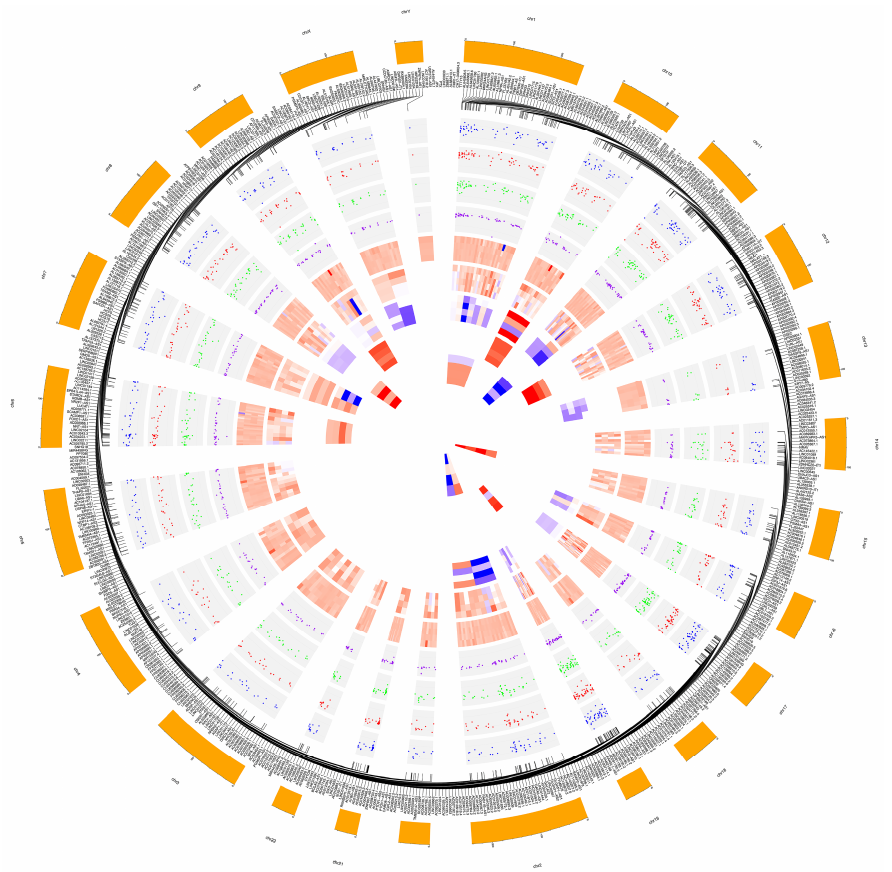
Figure 2. Circular plot made by CIRCOS [63] highlighting fold changes of significant dysregulated long non-coding RNAs (lncRNAs). Chromosome lncRNA host/target genes belong to and most dysregulated lncRNAs are labeled in the two outermost circles. Then, from outside to inside: dispersion plots of log 2 FC of all significant ( p < 0.05) different expressed lncRNAs in relationship to the whole treatment period (Due_to_Time), to the first considered time point vs basal time (3 h_vs_0 h), to the second time point vs basal time (6 h_vs_0 h) and to the second vs the first treatment time points (6 h_vs_3 h); heat maps for individual subtypes of significant ( p < 0.05) differentially expressed lincRNAs, antisense, sense_intronic, sense_overlapping, bidirectional_promoter, 3′_overlapping, one type in relation to the mean of all contrast groups (Due_to_Time, 3 h_vs_0 h, 6 h_vs_0 h and 6 h_vs_3 h) for each circle. Larger width means greater fold-change.